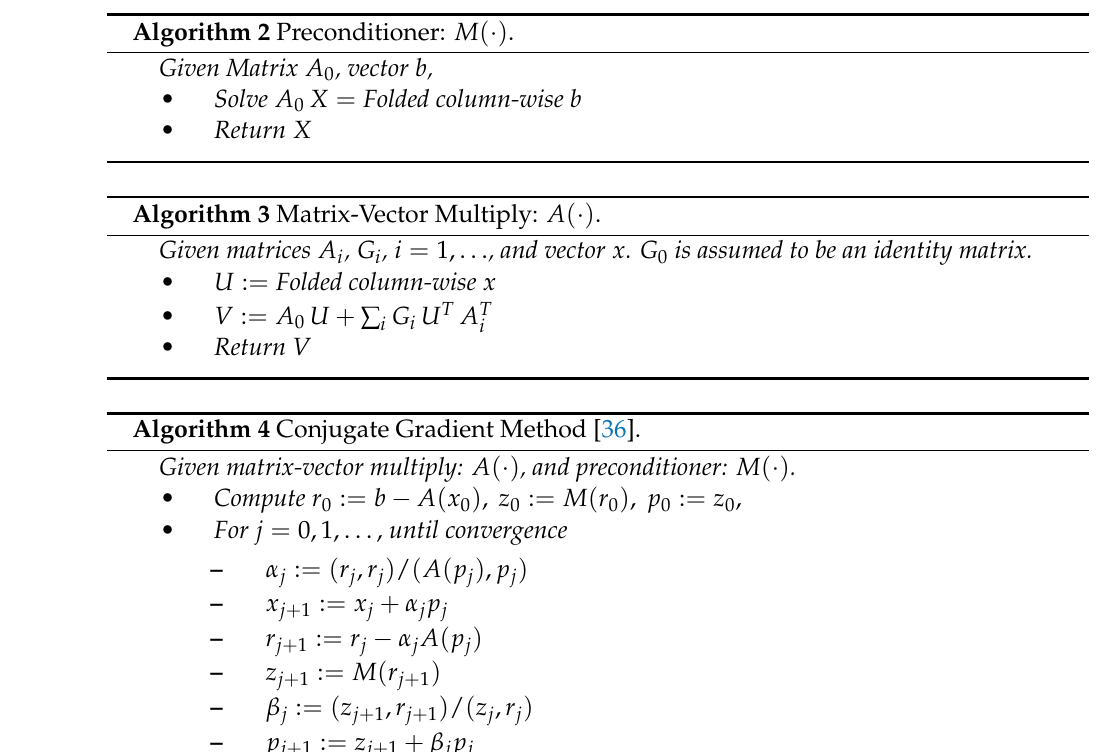
Algorithm 2 Preconditioner: M ( · ) .